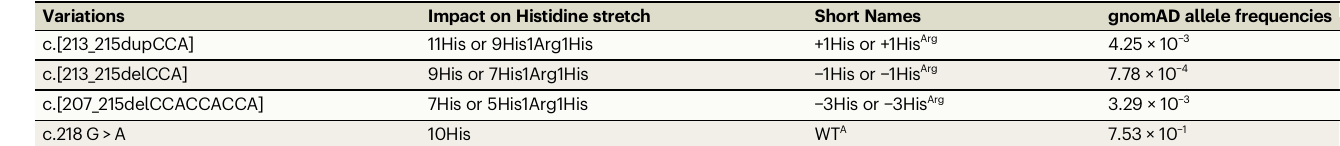
Table 3 | Reported HOXA1 variation frequencies in the Genome Aggregation Database